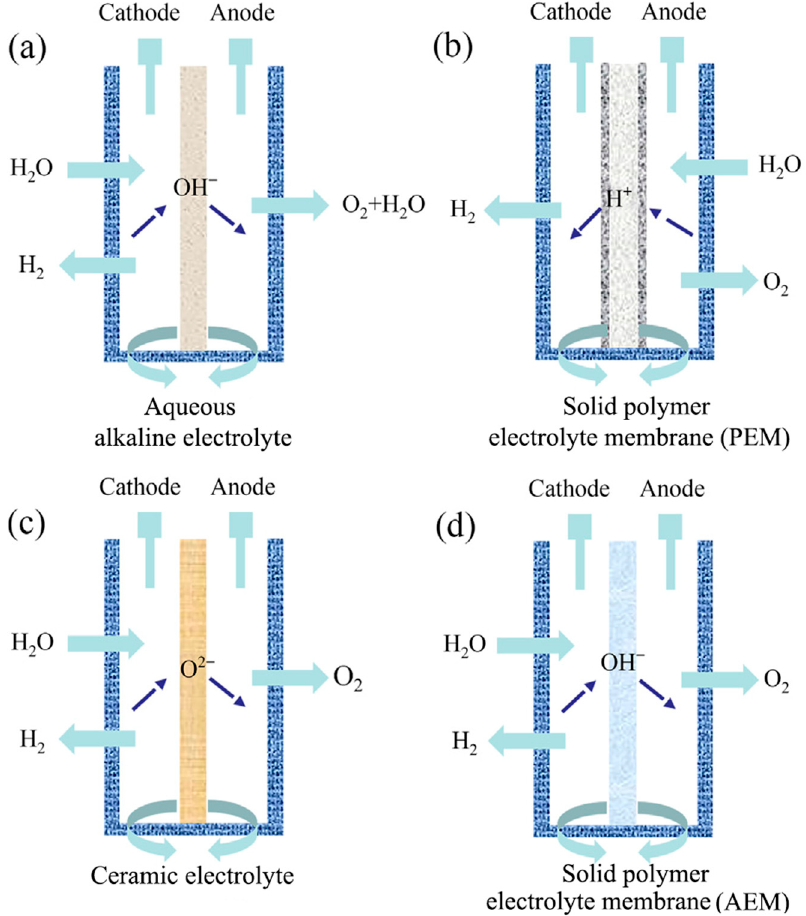
Figure 1. Representation of ( a ) AWE, ( b ) PEM, ( c ) SOEC, and ( d ) AEM electrolysis technologies. Adapted from [1] with permission from Elsevier.